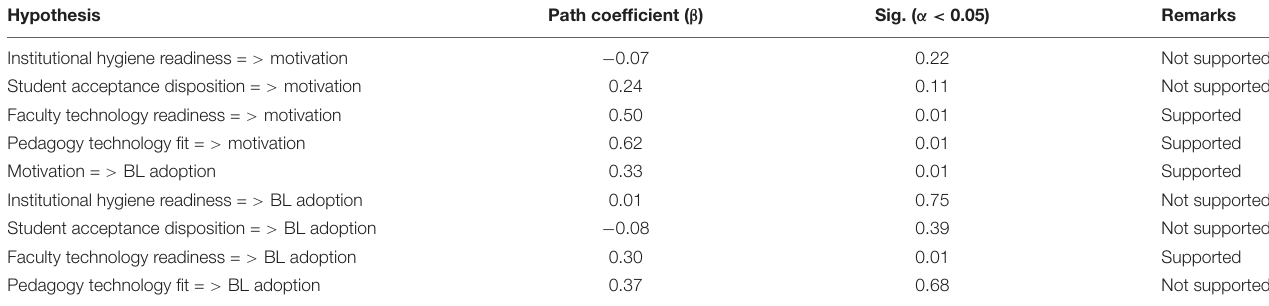
TABLE 6 | Hypothesized model.